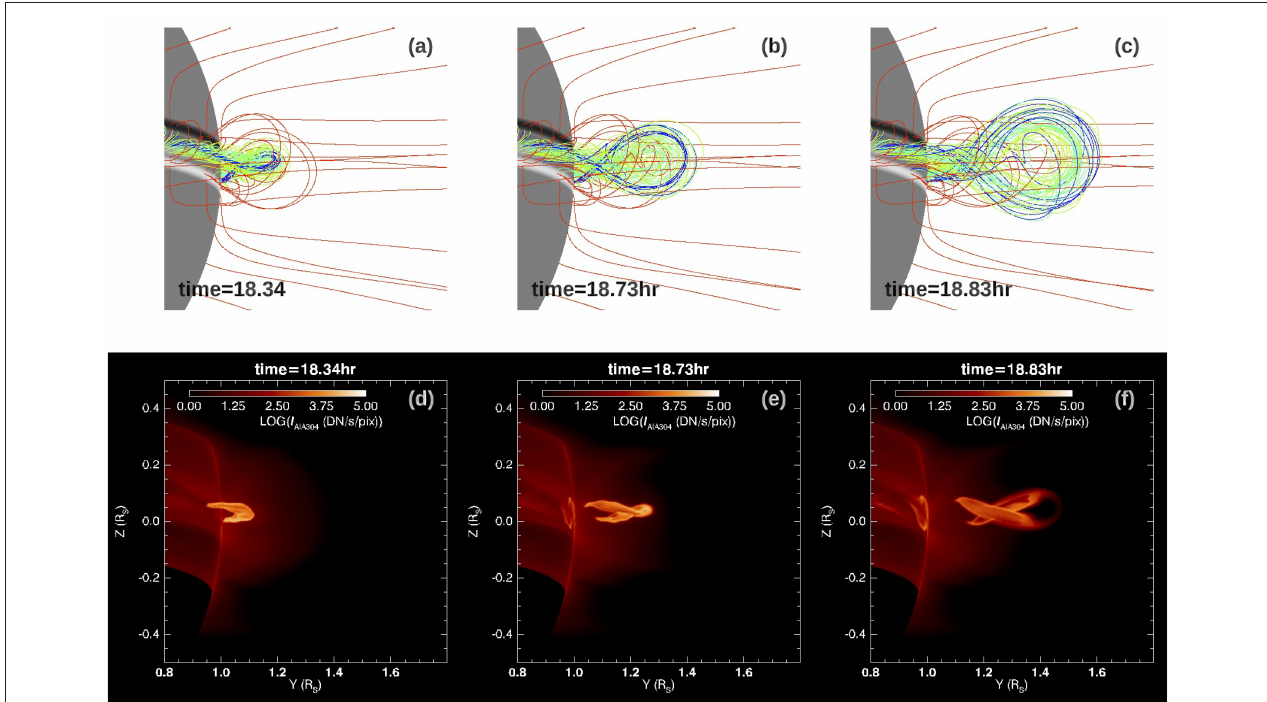
FIGURE 6 | Successive snapshots of the erupting flux rope field lines (a–c) and the corresponding synthetic AIA 304 Å images (d–f) , viewed with a LOS that is close to aligned with the length of the flux rope. They show the writhing motion of the flux rope and the associated erupting prominence.